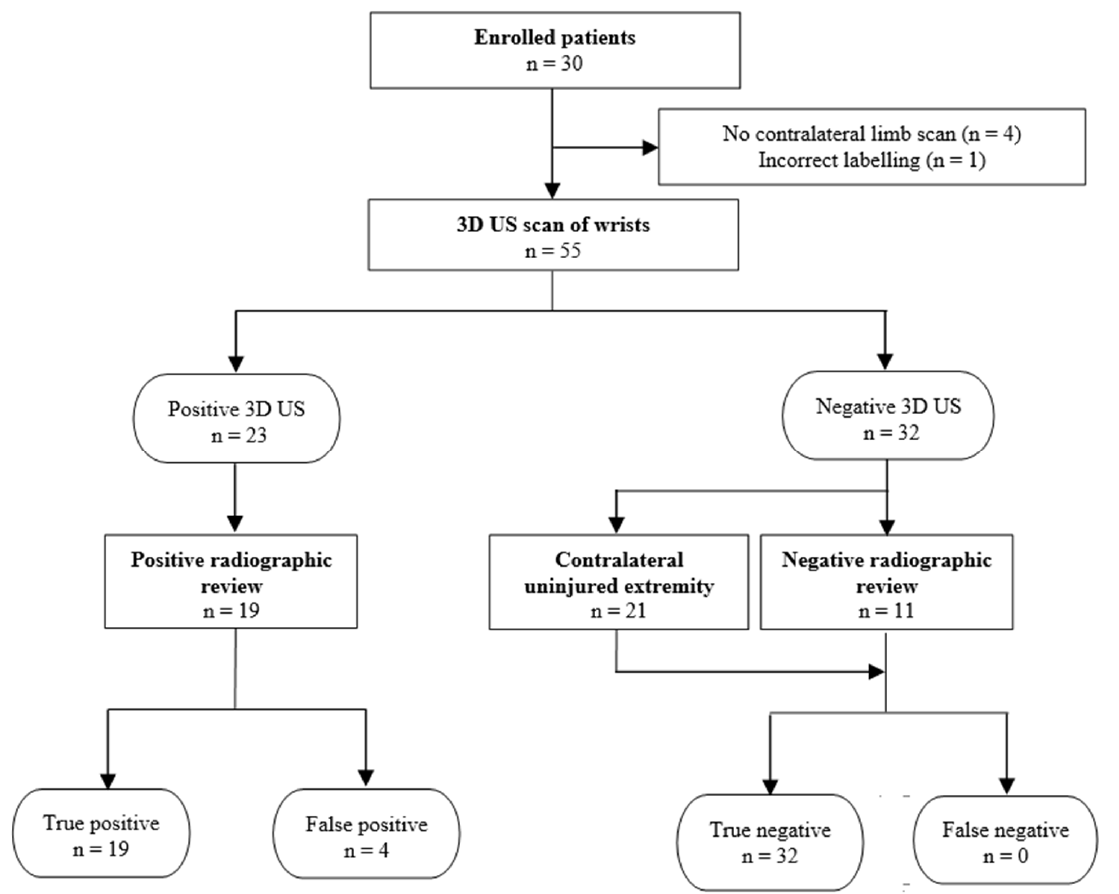
Figure 2. STARD flow diagram, showing the number of children who received the US and gold standard radiograph [15]. The US results are from combined readers.